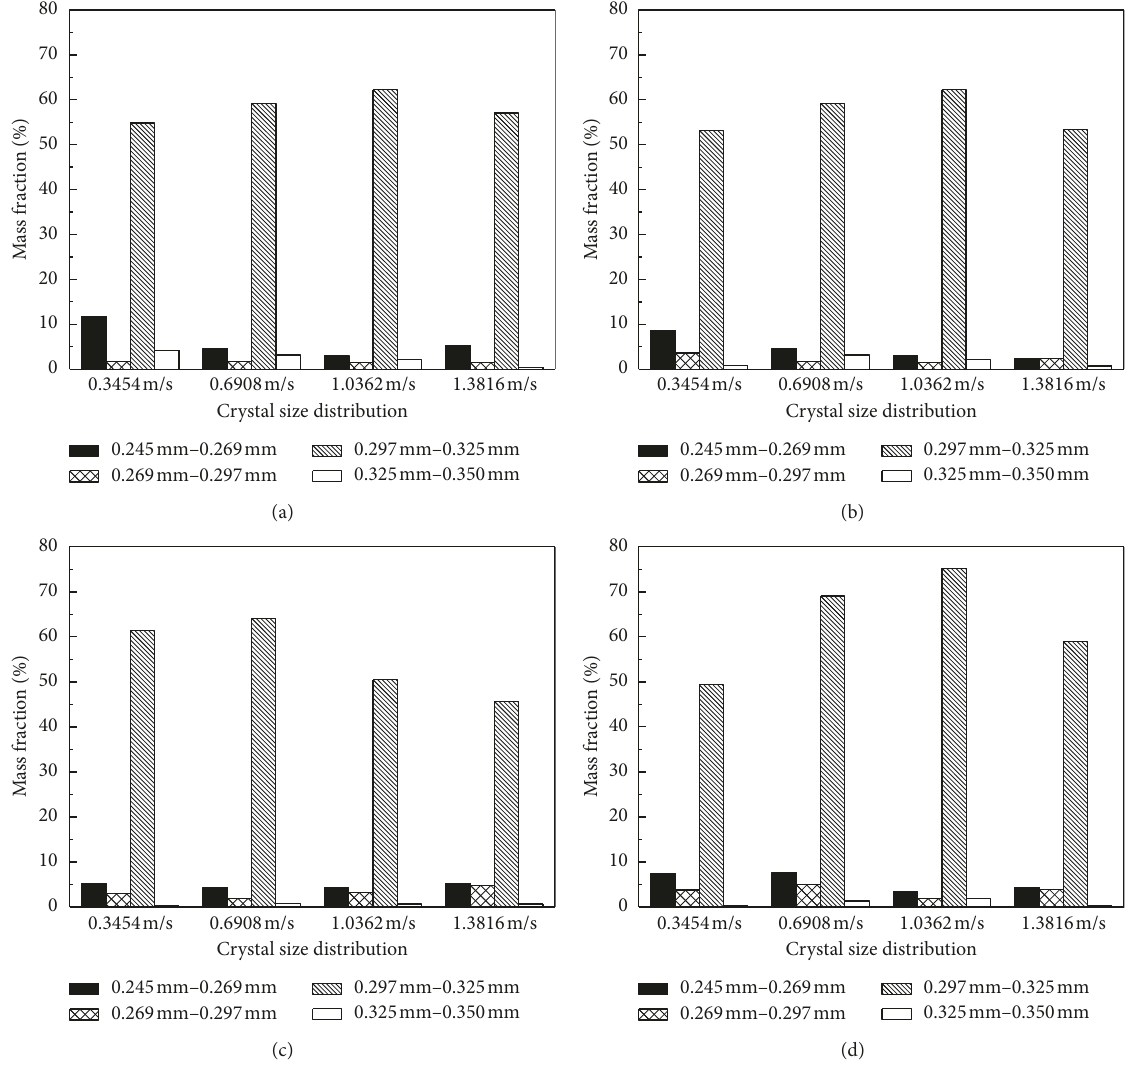
Figure 7: The influence of circulation flow rates on CSD for residence times of (a) 1200s, (b) 2100s, (c) 3000s, and (d) 3600s.